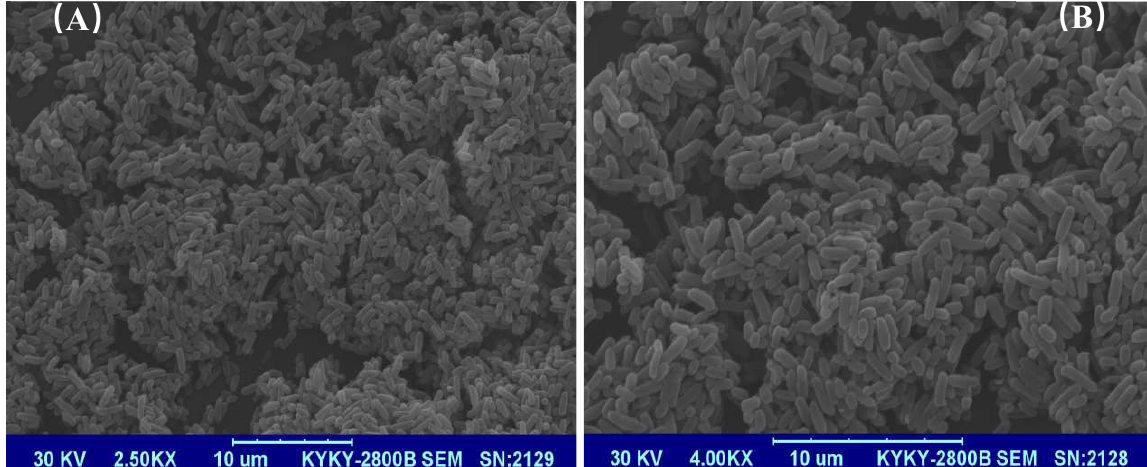
Figure 1. SEM images of strain Acinetobacter baumannii DP-2 at ( A ) 2.5KX and ( B ) 4.0KX.